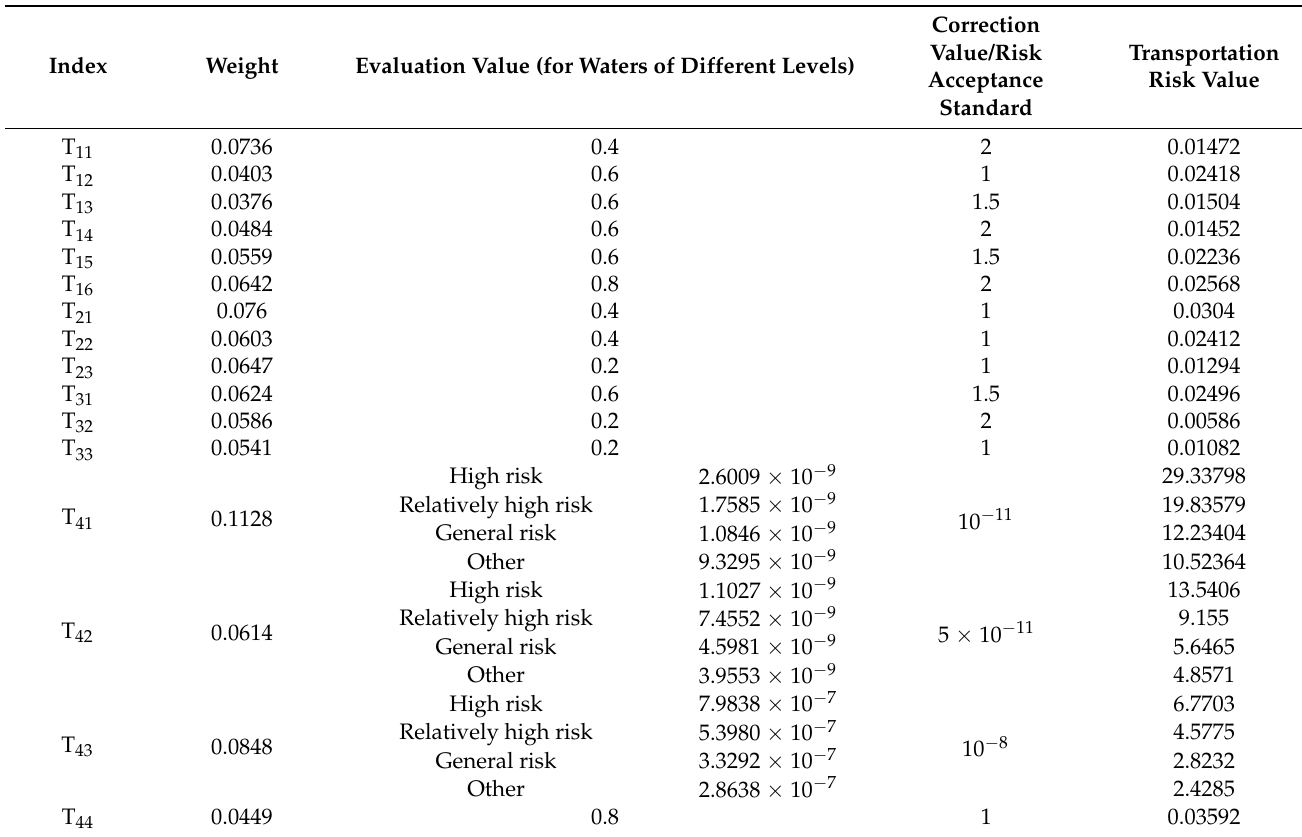
Table 14. Relevant values for indicator calculation.